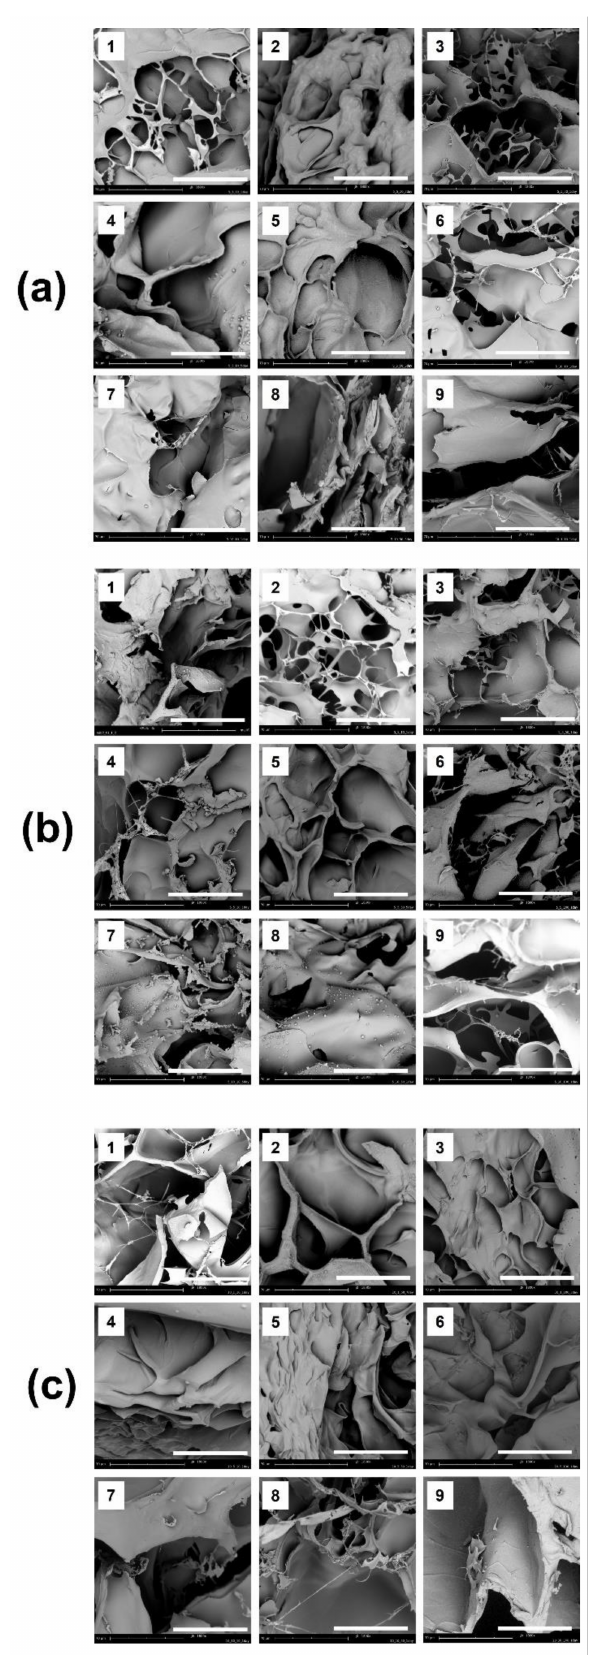
Figure 2. Surface morphologies of lyophilized 2-GHC-FD-1-9, 5-GHC-FD-1-9, and 10-GHC-FD-1-9 observed by FE-SEM at 1800 × . ( a ) 2-GHC-FD-1-9, ( b ) 5-GHC-FD-1-9, and ( c ) 10-GHC-FD-1-9. White scale bars indicate 70 µ